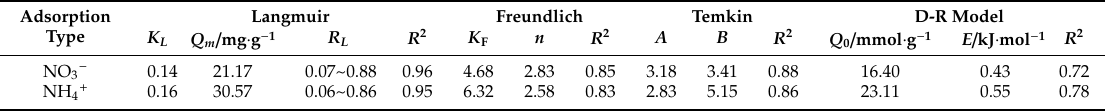
Table 4. Isotherm model parameters of NO 3 − and NH 4 + by